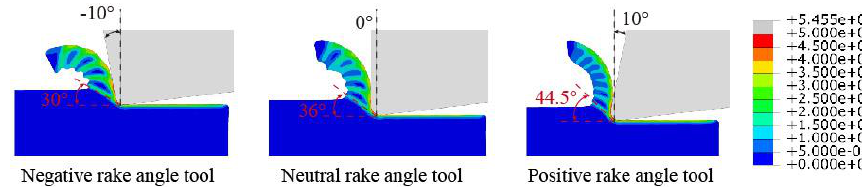
Figure 7. Simulated cutting process employing cutting inserts with different rake angles.